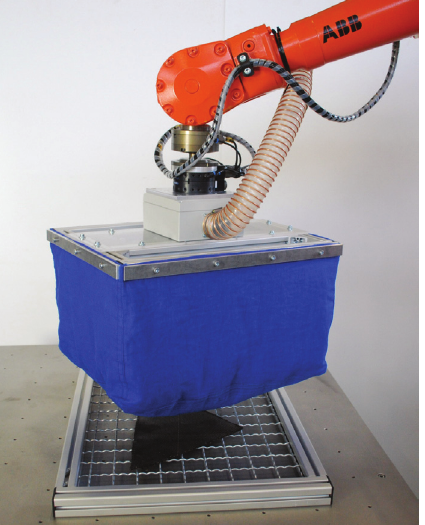
Figure 4 FormHand mounted to a six DOF industrial robot with con- nected vacuum supply.